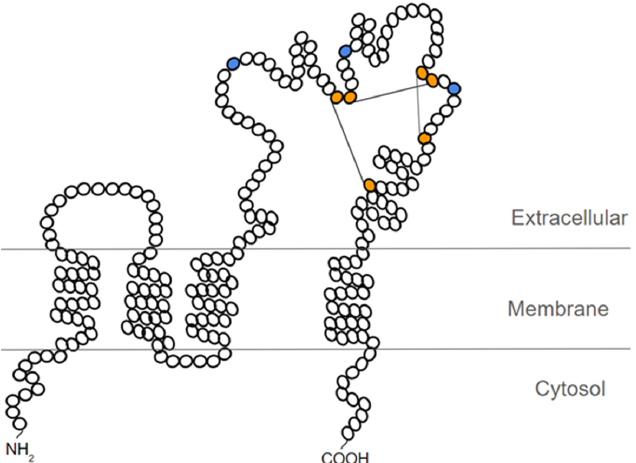
Figure 2. Schematic representation of the probable structure of CD63. In orange, the cysteine residues that form the 3 disulfide bridges are depicted. In blue, the N -glycosylation sites present in the large extracellular loop of CD63 are represented. Figure based on the representation proposed by Warner et al. [28].